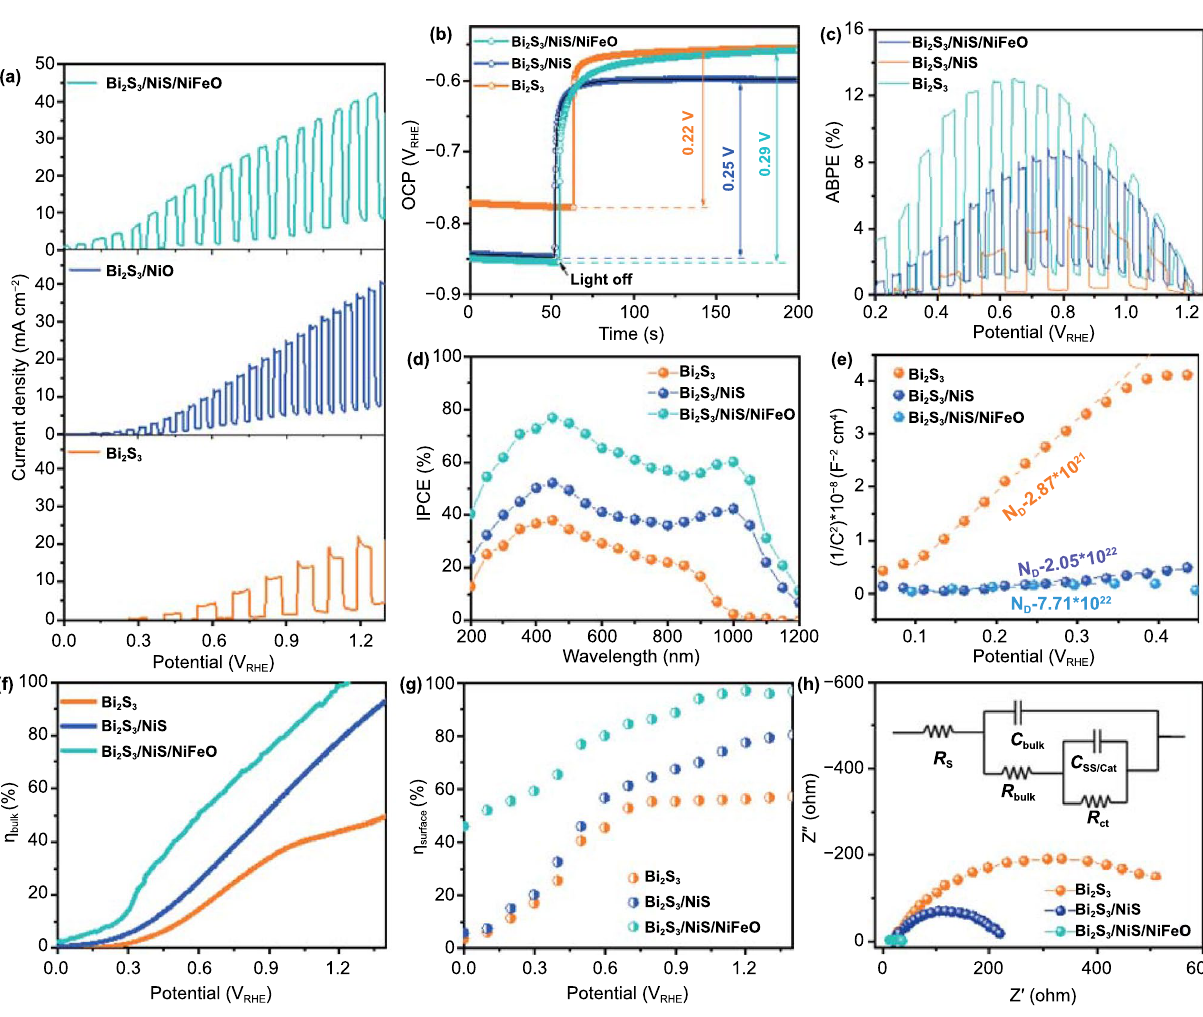
Fig. 3 a J – V curve measured under AM 1.5 G illumination, b open‑circuit decay curve, c ABPE analysis, d IPCE analysis, e Mott–Schottky plot using double‑layer capacitance measured by dark EIS, f charge separation efficiency, and g charge injection efficiency. h Nyquist plot